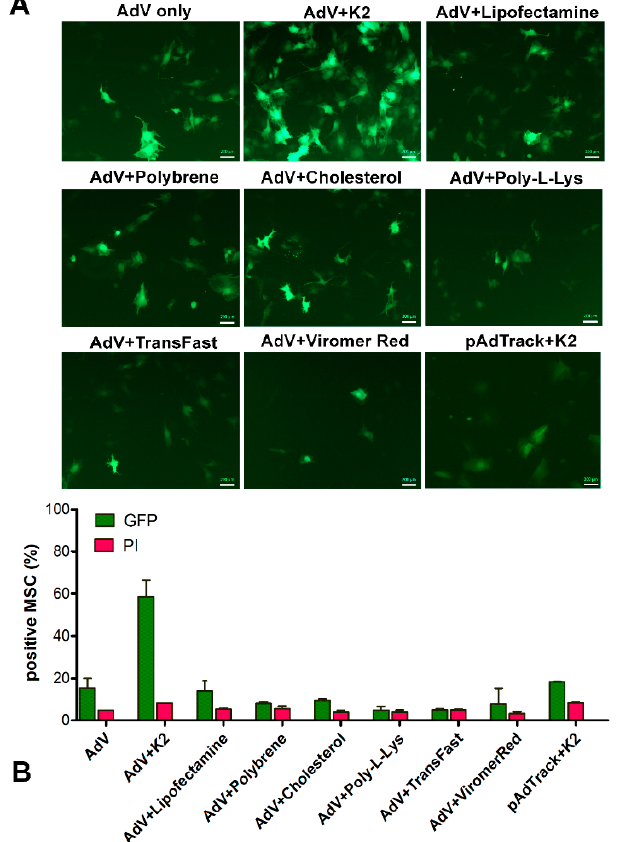
Figure 2. Adenoviral transduction of murine mesenchymal stromal cells in the presence of different potential transduction boosters. To induce GFP expression, MSC were incubated with 250 TU/cell adenovirus alone (AdV only) or in the presence of the K2 Transfection System (K2TS) (AdV + K2), Lipofectamine 3000 (AdV + Lipofectamine), 10 μ g/mL Polybrene (AdV + Polybrene), 2 μ g/mL free cholesterol (AdV + Cholesterol), 1 μ g/mL poly-L-Lysine (AdV + Poly-L-Lys), TransFast (AdV + TransFast), or Viromer Red (AdV + ViromerRed). In parallel, MSC were transfected with pAdTrack- CMV using K2TS (pAdTrack + K2). After 48 h, the GFP expression was observed by fluorescence microscopy ( A ), and the number of the GFP-expressing cells was determined by flow cytometry ( B ). The percentage of GFP-positive cells determined by flow cytometry is represented by green columns and that of the dead cells colored with propidium iodide (PI)—in red columns. As is revealed, the K2TS is the most efficient reagent for boosting the adenoviral transduction of MSC. Bars, 20 µ